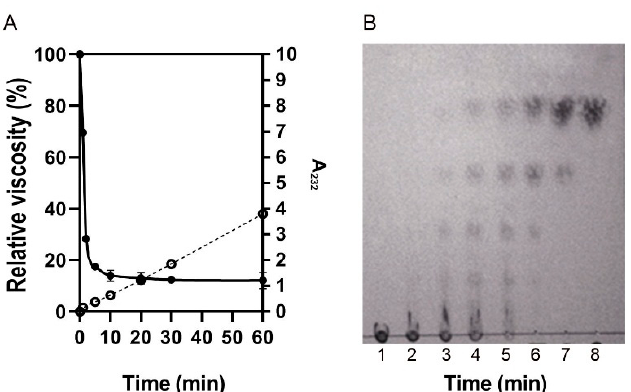
Figure 9. Viscosity analysis of enzymatic pattern and TLC analysis of the reaction pattern of enzyme: ( A ) Viscosity analysis; ( B ) TLC analysis, from left to right are 0, 5, 10, 20, 30, 60, 120, 240 min, respec- tively.